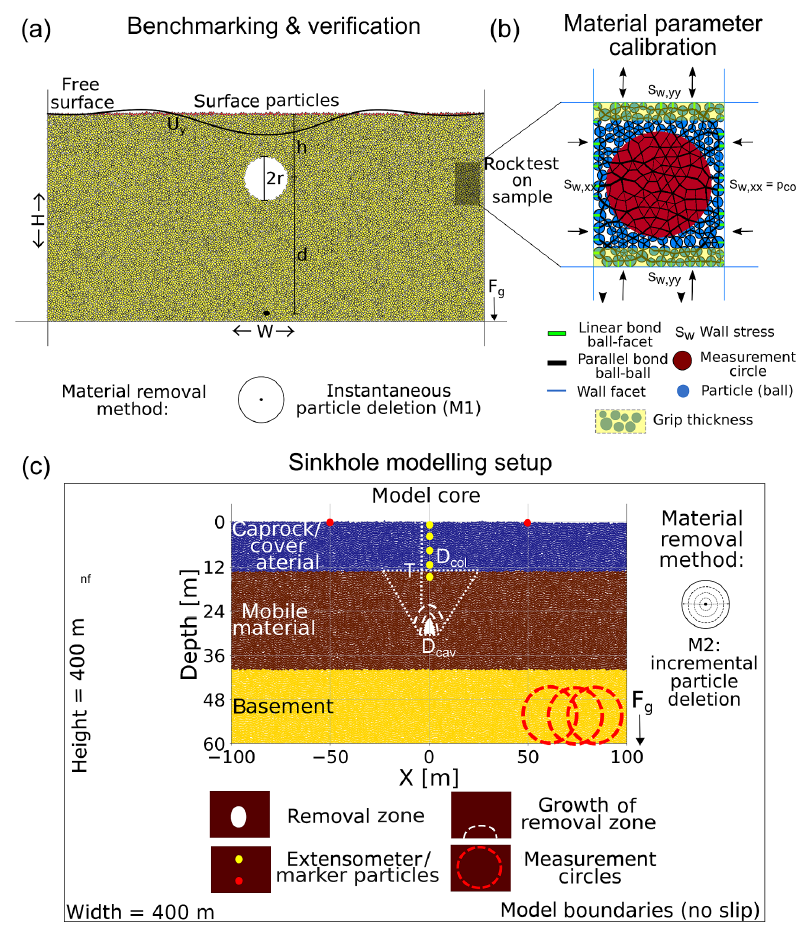
Figure 4. Setups for model benchmarking, calibration and sinkhole simulation. Panel (a) indicates model verification and benchmarking. A circular cavity of radius r = 5m is placed instantaneously at a depth h = 35m and a distance d = H − h from a fixed point at the bottom of a box of varying dimensions H × W and particles of radii R subject to the body force due gravitational acceleration F g . Panel (b) indicates rock tests for material parameter calibration. A sample is contained within walls that are used for applying confining pressure simulating the materials’ response at different depth. A servo-mechanism controls the walls’ axial velocity. For a tensile test, grips of certain thickness are defined at the bottom and top of the sample and moved outwards. (c) Sinkhole simulation by quasi-static incremental single void growth. T/D is referring to the overburden thickness to diameter ratio of either a stable cavity ( D = D cav ) or an unstable collapse zone ( D = D col ). Yellow/red circles represent particles that act as extensometers/markers, respectively. Big red circles indicate overlapping measurement circles distributed within an area of interest. Table 1. Bulk properties of the particle assemblies used in the benchmarking of DEM cavity formation models vs. analytical solutions and BEM. Bulk parameter (unit) Symbol Unit Value